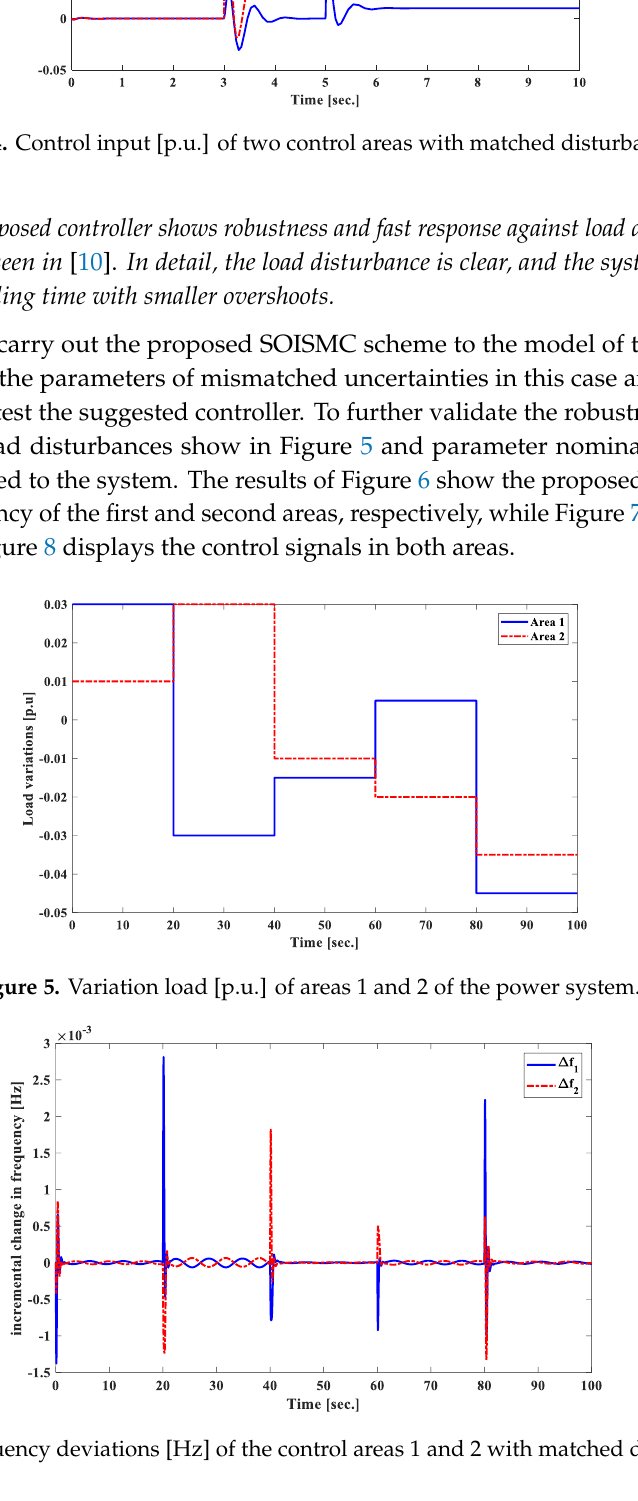
Figure 4. Control input [p.u.] of two control areas with matched disturbances.